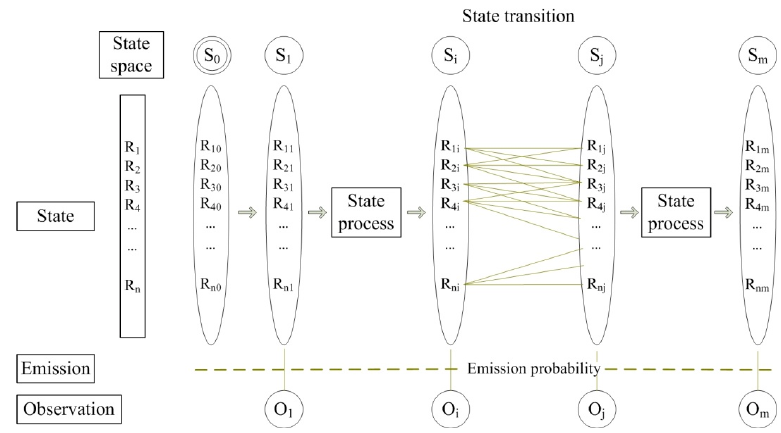
Figure 2. Modeling the map-matching with HMM.